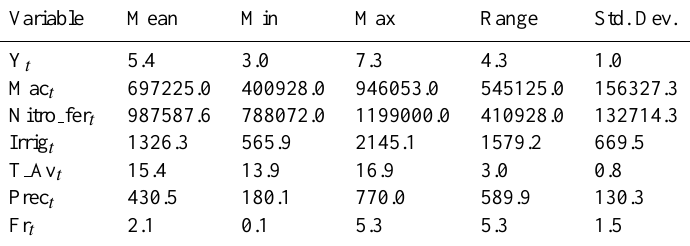
Table 7. Descriptive statistics (mean, min, max, range and standard deviation) of the variables used in the crop yield regression